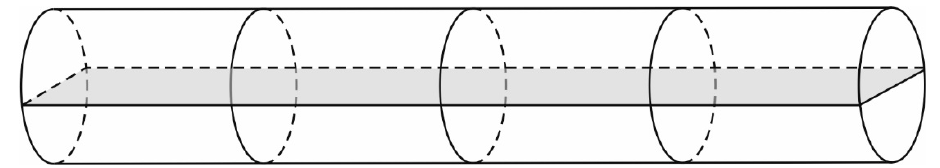
Figure 3. The geometry of the fracture in the composite core.